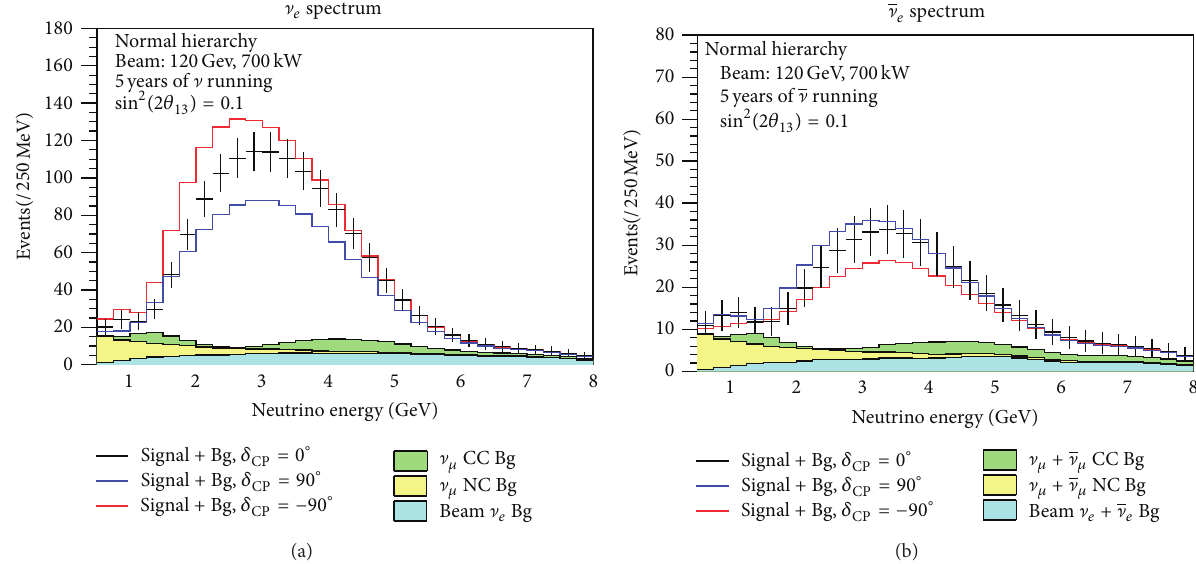
Figure 12: Estimated events for the LBNE experiment running for 5 years of neutrino and 5 years of antineutrino with 700 kW of 120 GeV protons on target and with the assumption that sin 2 2𝜃 = 0.1 . Backgrounds and changes with 𝛿